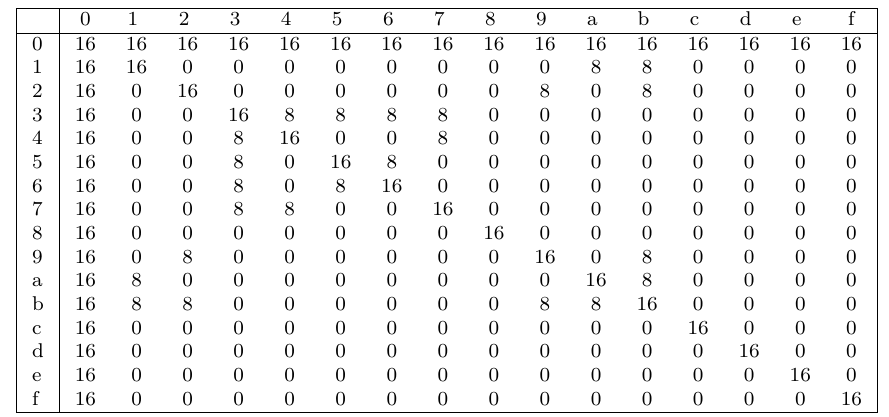
Table 1: FBCT of the Sbox S 2 of LBlock